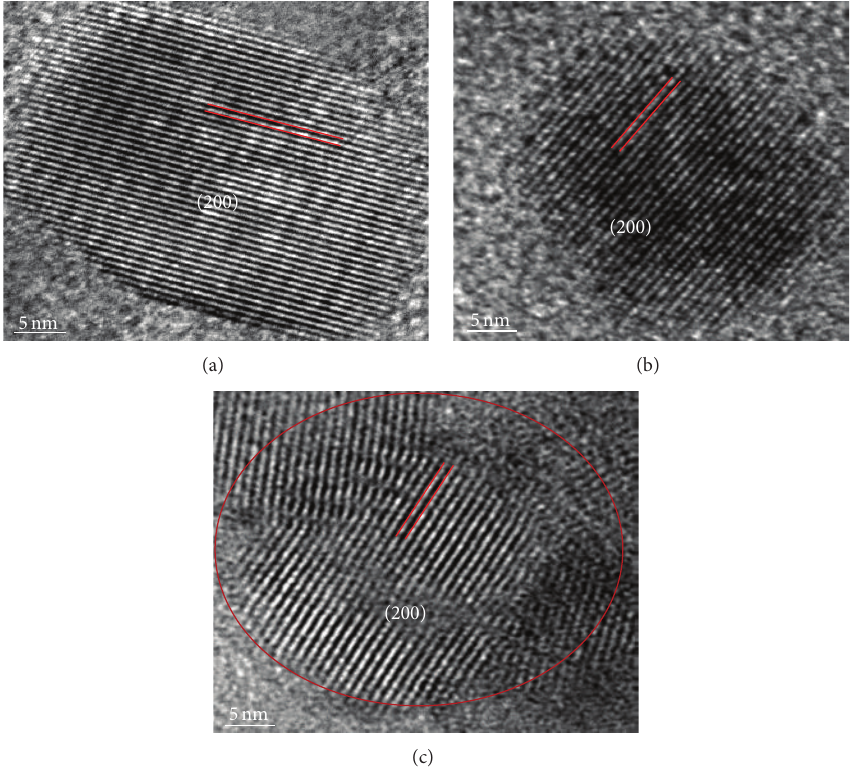
Figure 3: TEM images of (a) PbS, (b) Bi-doped-PbS, and (c) Ag-doped-PbS QDs.